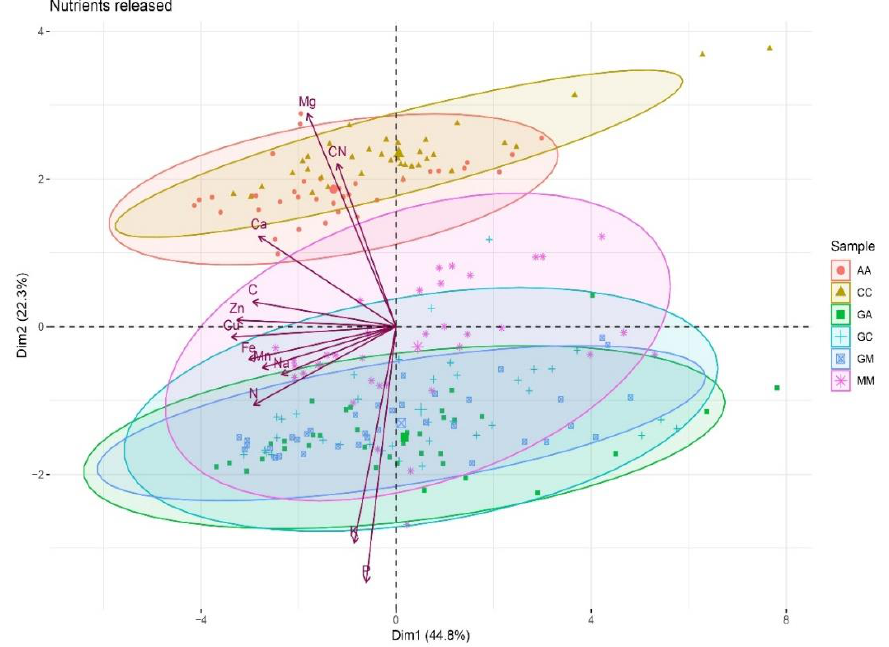
Figure 6. Principal component analysis (PCA) performed with the element concentrations of all the pruning waste studied. pruning waste